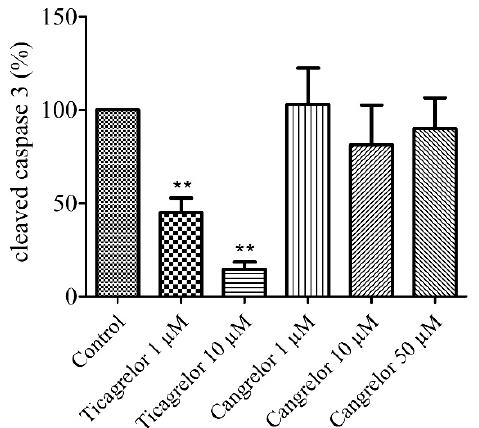
Figure 3. Ticagrelor but not cangrelor induced an anti-apoptotic effect. Cells were treated with ticagrelor 1 µM, 10 µM or with cangrelor 1 µM, 10 µM and 50 µM. Results are expressed as means ± sem ( n = 6/group) of relative cleaved caspase 3 expression (%) in the human umbilical vein endothelial cells (HUVECs) after 2 h of hypoxia. **: p < 0.01 compared to control without any treatment.